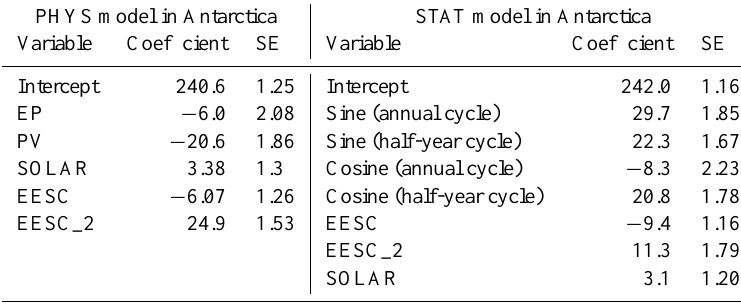
Table 6. Regression coefficients and standard errors of regressions at 80 ◦ S, 0 ◦ E